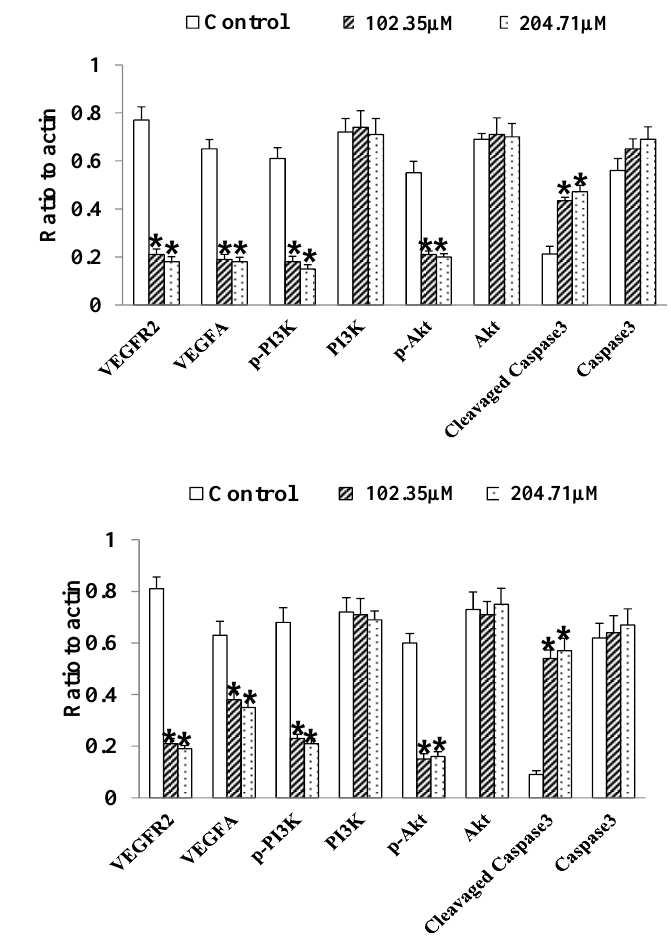
Figure 5. The protein levels of the angiogenesis-related pathway in HCT116 cells and DLD1 cells. ( A ) Western blot bands of the proteins of VEGFA/VEGFR2/p-PI3K/PI3K/p-Akt/Akt/cleavaged Caspase-3/Caspase-3 pathway. ( B ) Statistical data of the proteins expression levels in HCT116 cells. ( C ) Statistical data of the proteins’ expression levels in DLD1 cells. All data are presented as mean ± SD, * p < 0.05 compared with the normal group, n =